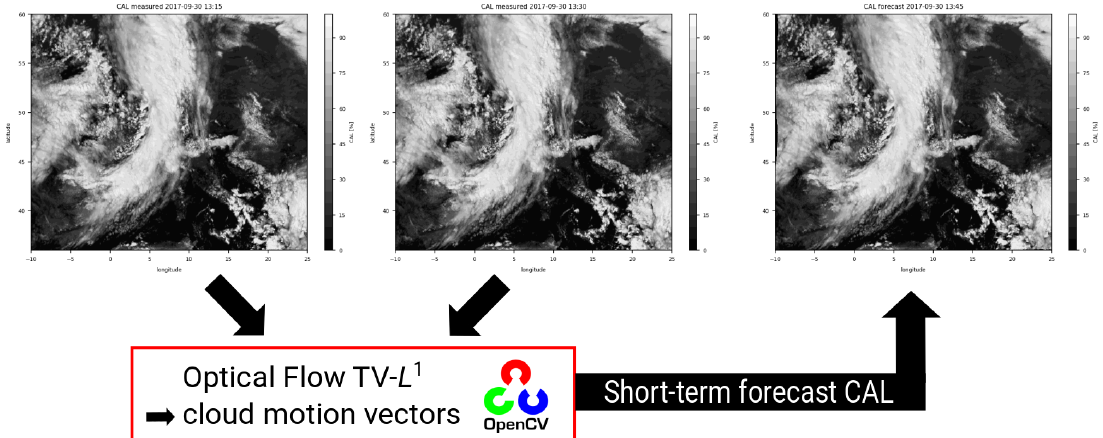
Figure 1. Scheme of the optical flow method. Two images of the effective cloud albedo serve as input for the TV- L 1 method. The estimated cloud motion vectors are then applied to the latter of the consecutive images to extrapolate the cloud motion into the